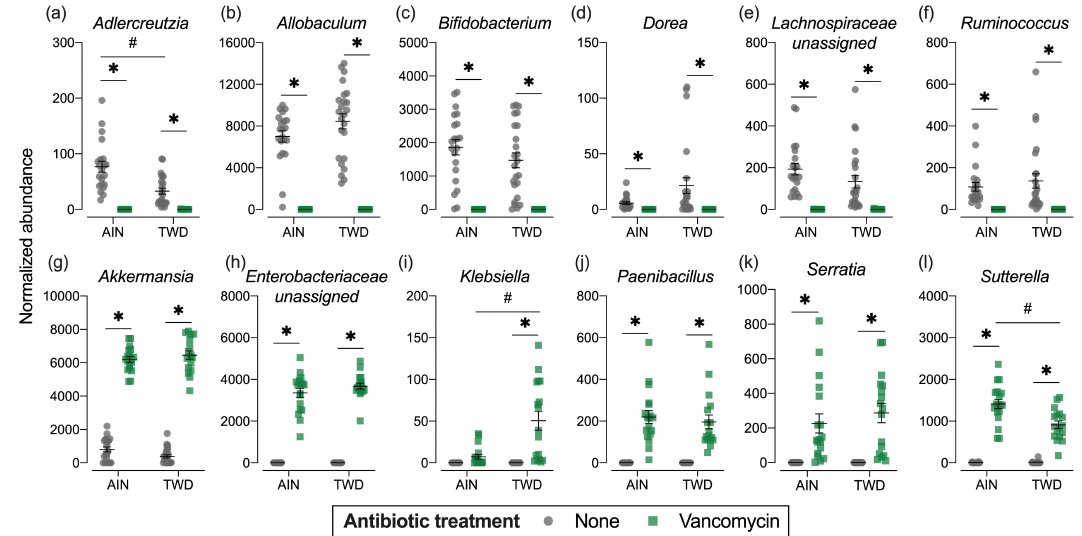
Figure 7. Normalized abundance of selected microbiota taxa at the family or genus level for experimental groups. Values shown are the individual measurements for each animal with the mean ± standard error ( n = 17 to 23). * indicates a significant effect of vancomycin (FDR-adjusted p < 0.05) compared to untreated control within each diet group; # indicates a significant effect of diet (FDR-adjusted p < 0.05) comparing TWD to AIN diet within each antibiotic group as determined by metagenomeSeq using a zero-inflated gaussian fit statistical model. See Table S2 for specific p -values for pairwise comparisons and for other taxa. Abbreviations: AIN, the AIN93G diet; TWD, the total Western diet; Ab,